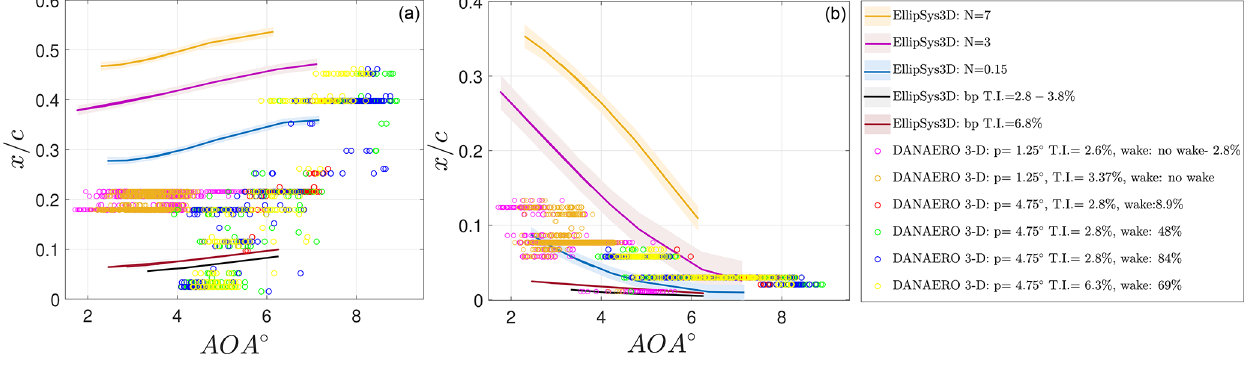
Figure 16. Detected transition locations from the EllipSys3D computations and the DAN-AERO field experiments for the pressure (a) and suction (b) sides, regrouped and regenerated from Özçakmak et al.